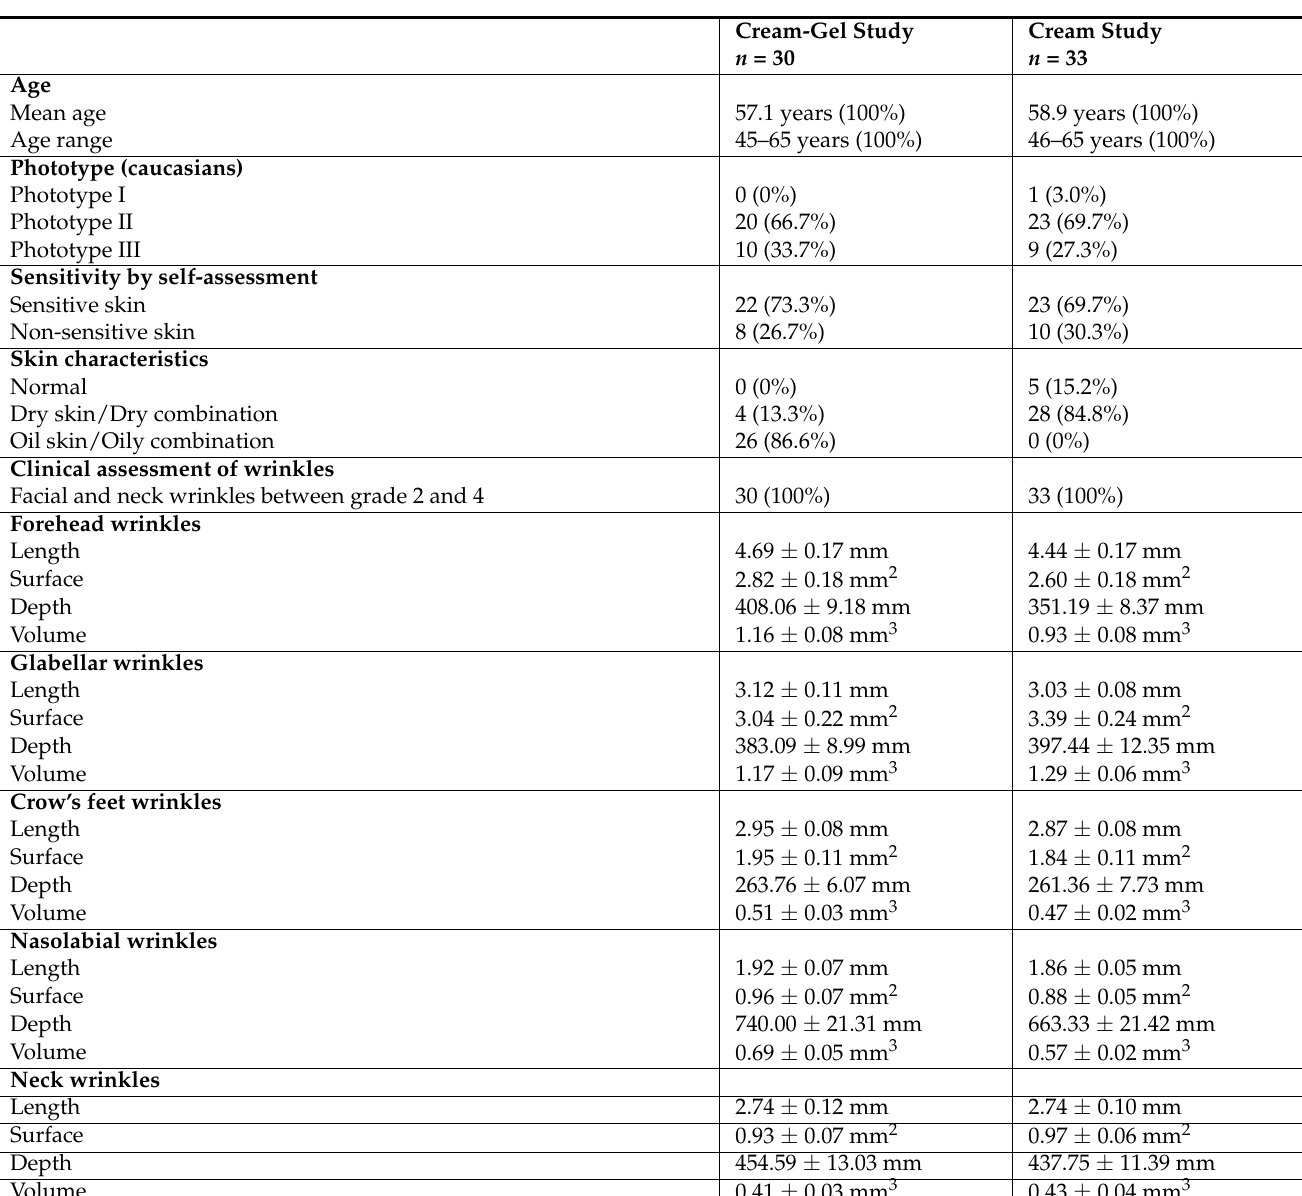
Table 3. Subject demographics. Two independent observational open-label monocentric studies were performed to evaluate the cream-gel and cream individually in human subjects on the face and neck for 56 days. Baseline data were collected prior to treatment. Wrinkle parameters measured were length, surface, depth and